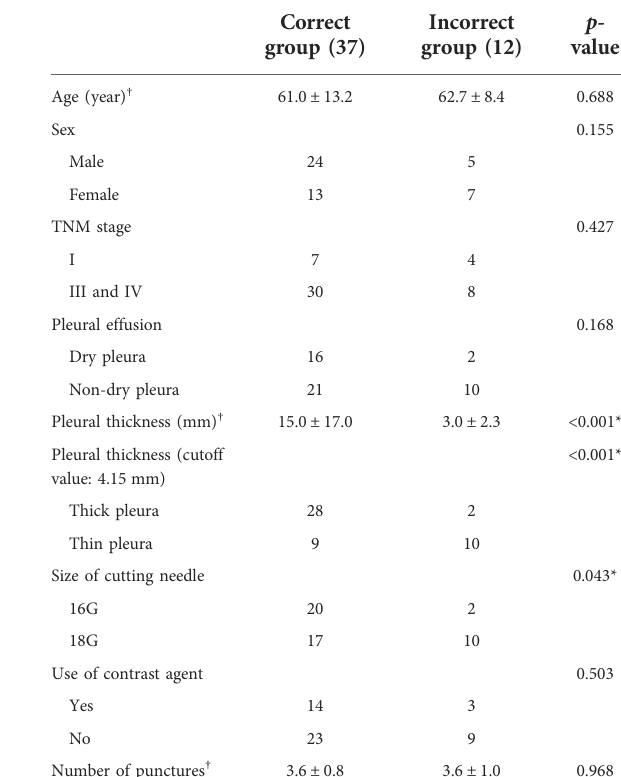
TABLE 2 Variables between correct group and incorrect group.